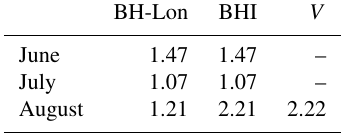
Table 2. Variance inflation factor (VIF) of the predictors selected in the MLR mode for June, July, and August.